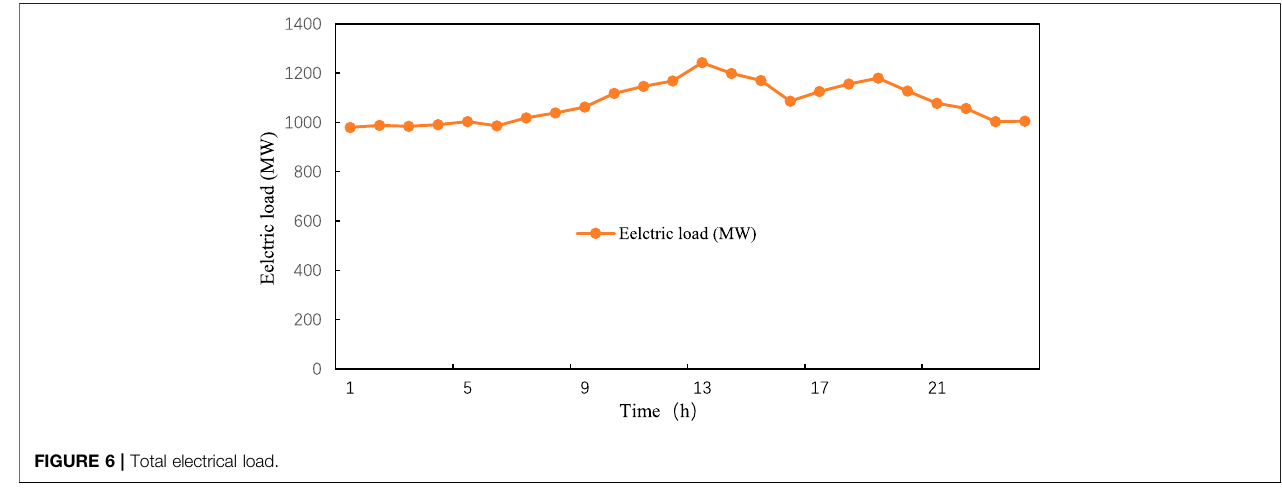
FIGURE 6 | Total electrical load.